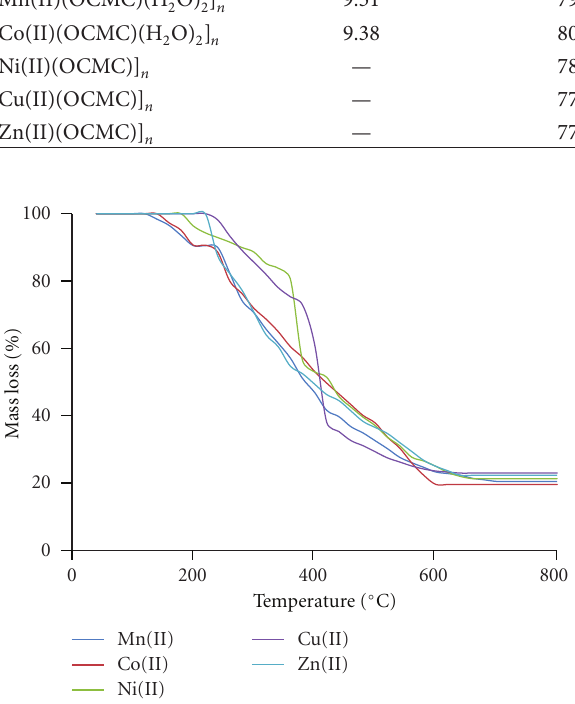
F 3: ermogram of OCMC-M Metallic Gel